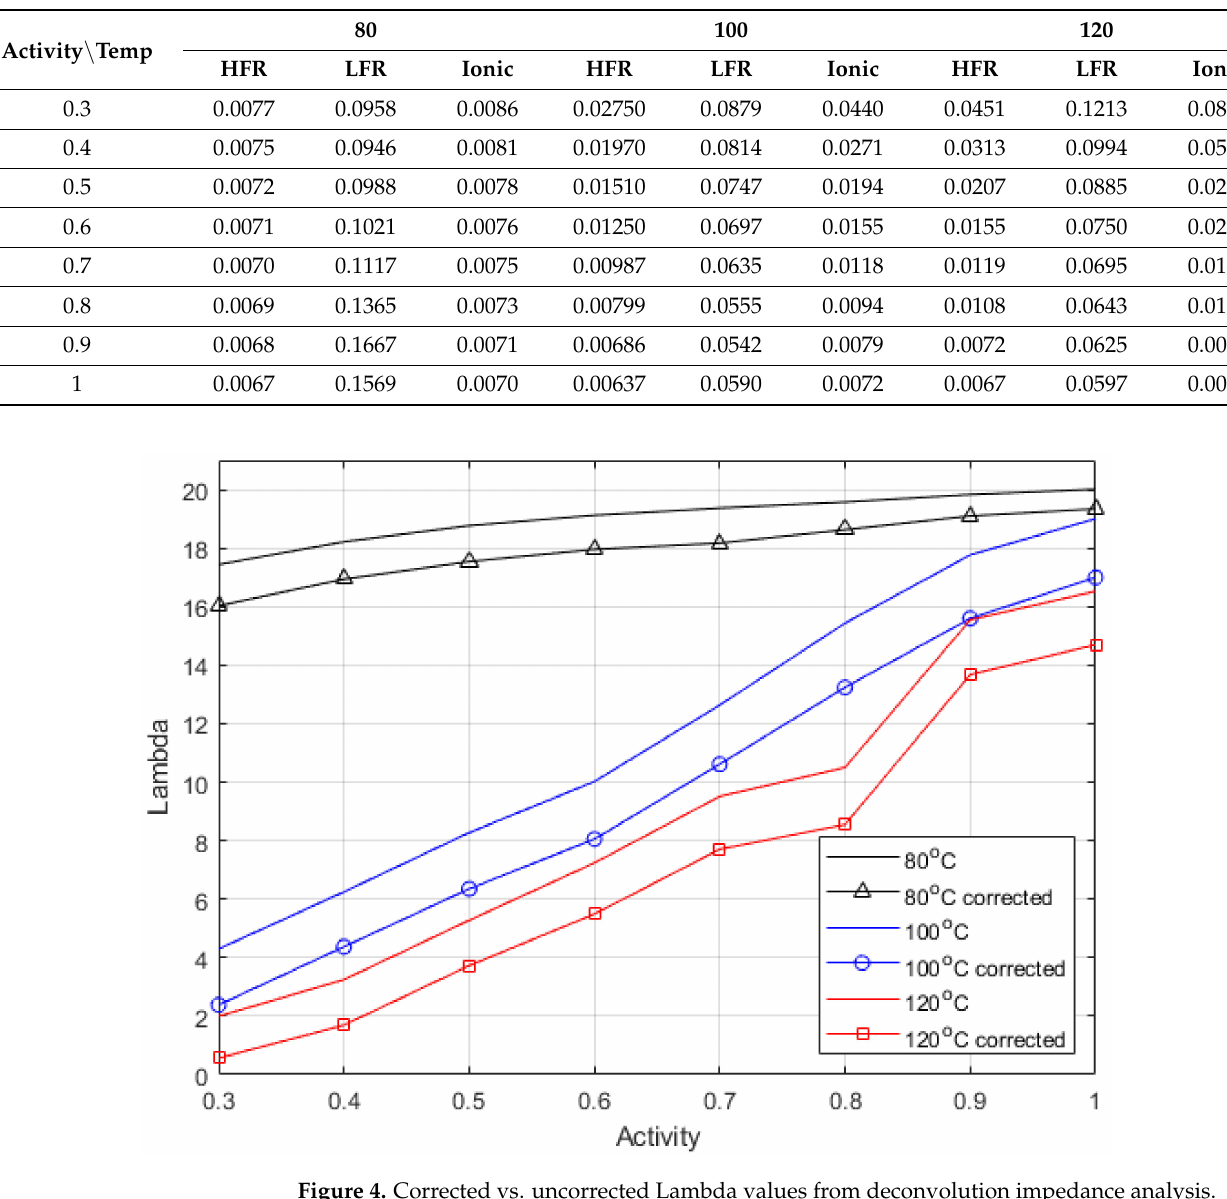
Table 5. HFR intercept ( Ω .cm 2 ) compared to the calculated ionic resistance from Pickup’s group’s work [52–55,57].